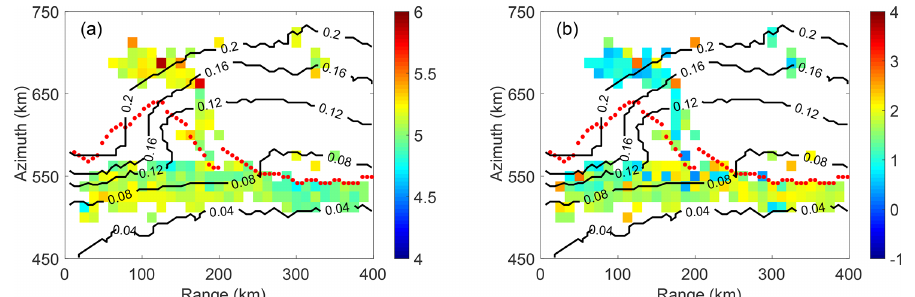
Figure 7. (a) Distribution of log 10 G in an averaged 12 . 5km × 12 . 5km grid in the range–azimuth plane. Cell color indicates the averaged log 10 G of all pairs with midpoints inside a cell; contours indicate SMOS ice thickness; red dots indicate the FAL. (b) Same as panel (a) except log 10 G is replaced with log 10 ν